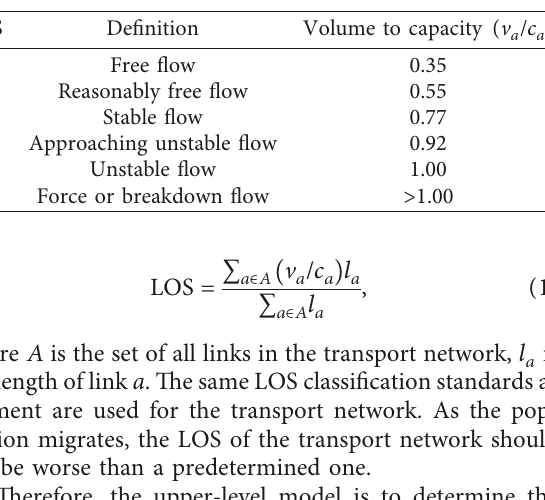
Table 1: LOS for a basic highway